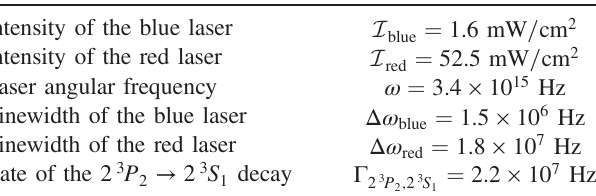
TABLE I. Parameters of the incident laser radiation and of the Li þ ion used in the evaluation of the transition rates. All parameters are given in the rest frame of an ion, moving with the relativistic velocity β ¼ 0 . 338